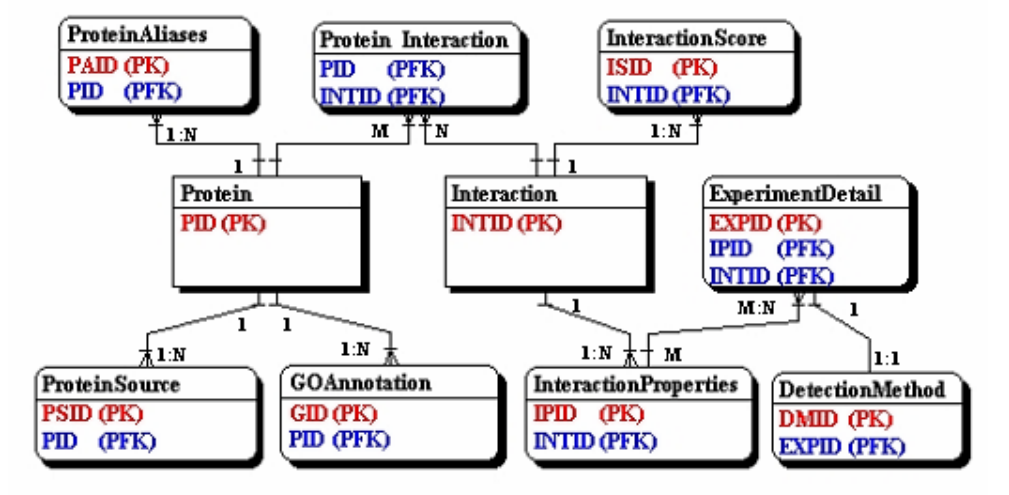
Figure 2: An entity-relationship diagram of UniHI, showing key tables (rectangles) and relations (lines). PK (red) and PFK (blue) denote primary and foreign